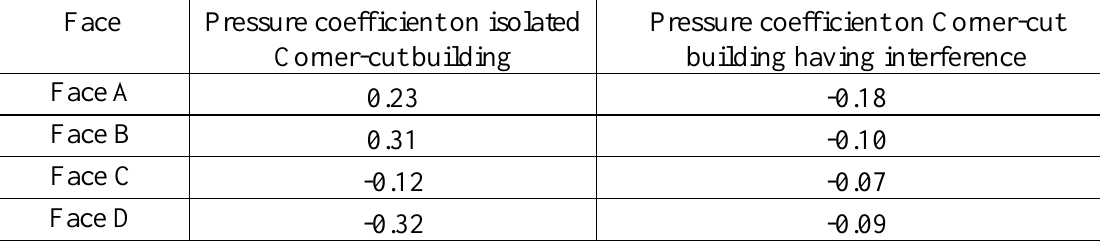
Mean pressure coefficient on corner-cut building, with and without interference at 90° wind incidence